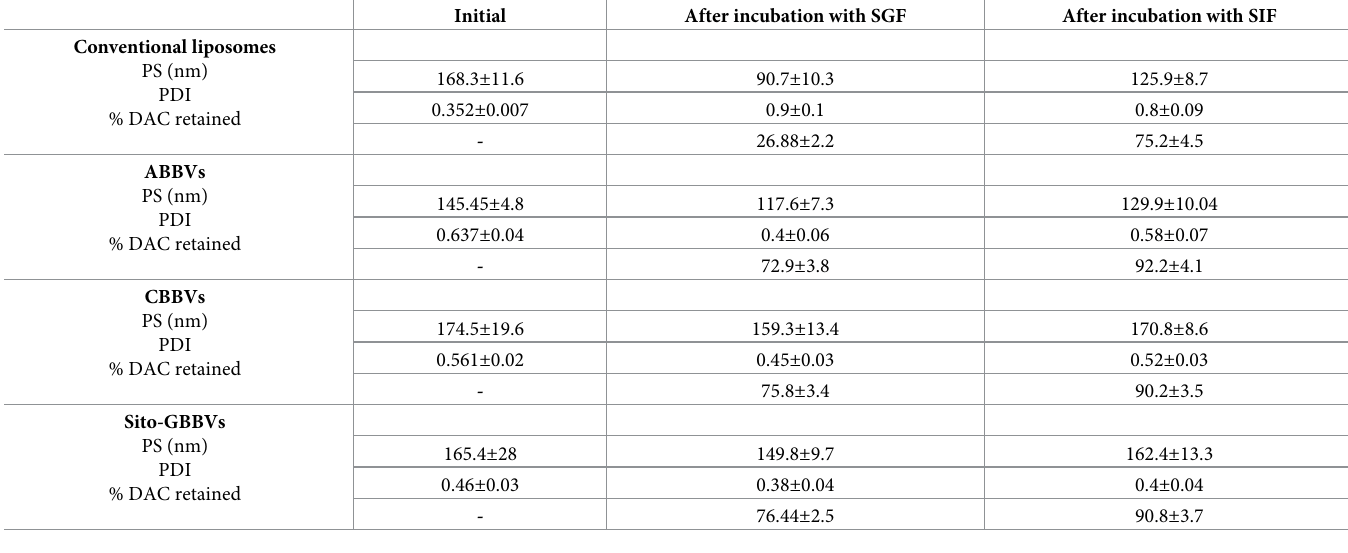
Table 3. Effect of simulated biological fluids on different characteristics of prepared miniaturized BBVs. Initial After incubation with SGF After incubation with